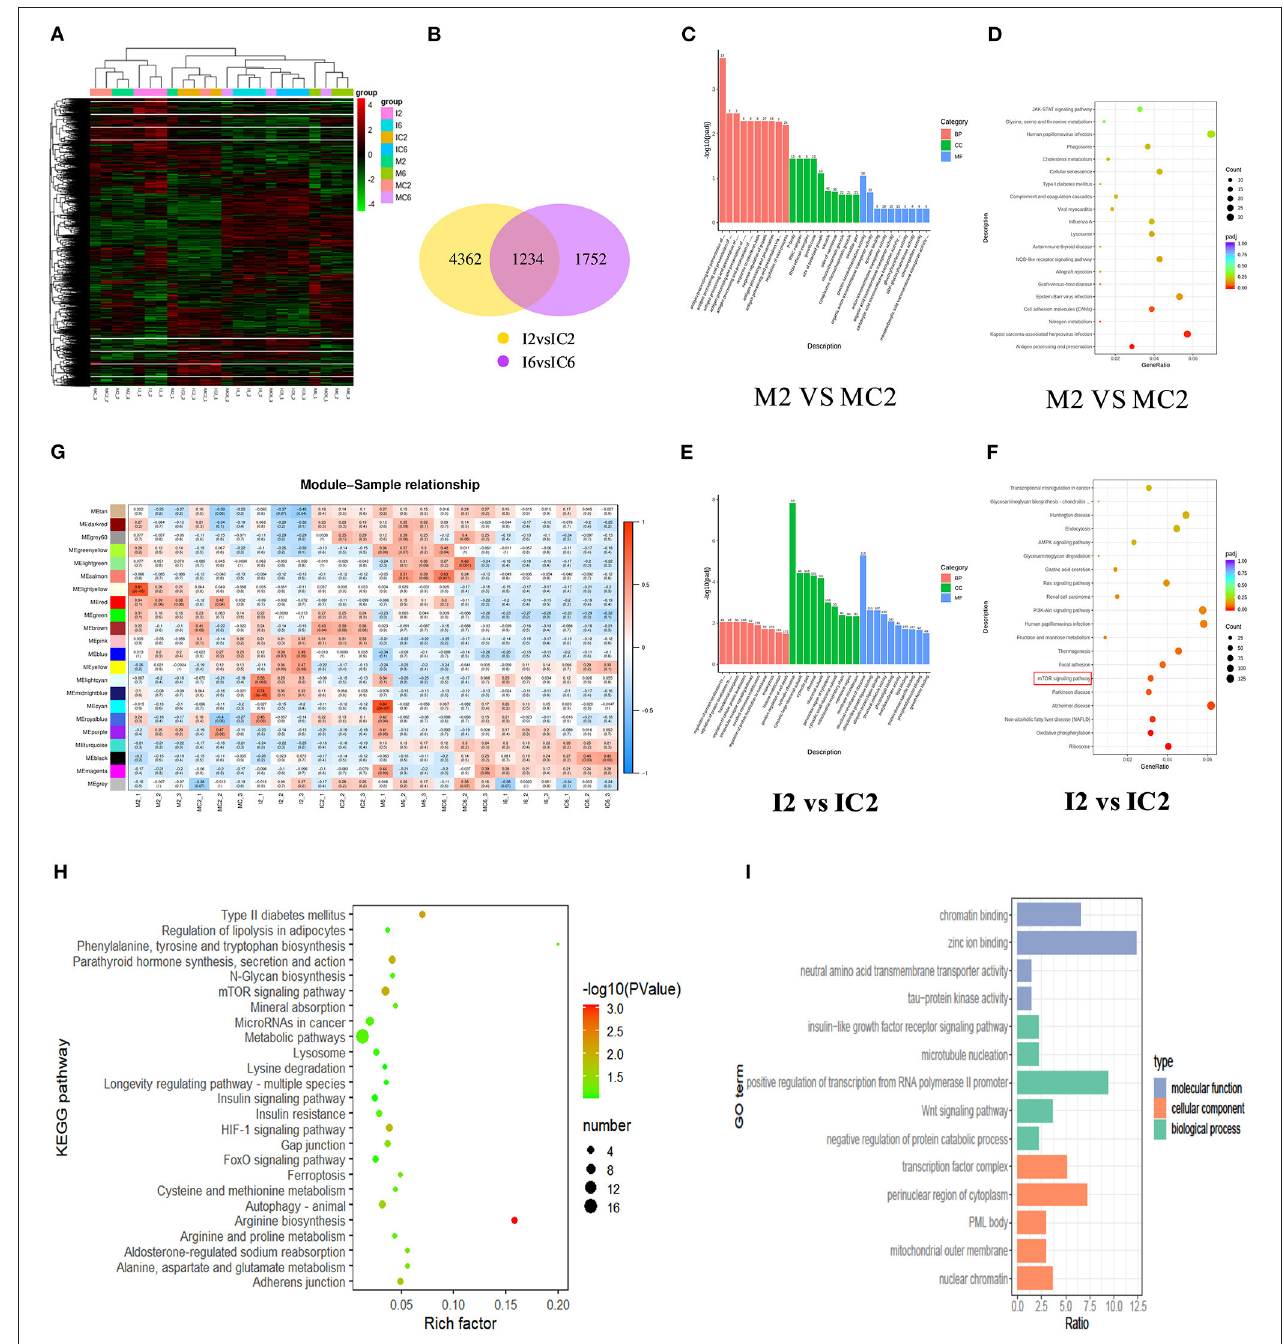
FIGURE 4 | GO and KEGG analysis of bovine adipocytes DEG and WGCNA analysis. (A) Differentially expressed gene clustering heat map. The abscissa is the sample name, and the ordinate is the normalized value of the differential gene FPKM. Red color indicates higher expression levels, while green represents lower expression levels; (B) The DEGs represented by a Venn diagram. Venn diagram showing the overlapping portion by sharing the expression pattern of the DEGs; (C) GO enrichment analysis of mimic treatment group and mimic NC group on the second day; (D) KEGG pathway enrichment analysis of mimic treatment group and mimic NC group on the second day; (E) GO enrichment analysis of inhibitor treatment group and inhibitor NC group on the second day; (F) KEGG pathway enrichment analysis of inhibitor treatment group and inhibitor NC group on the second day; (G) Correlation thermogram between samples and modules; (H) KEGG enrichment analysis of Midnightblue modules; (I) GO enrichment analysis of Midnightblue